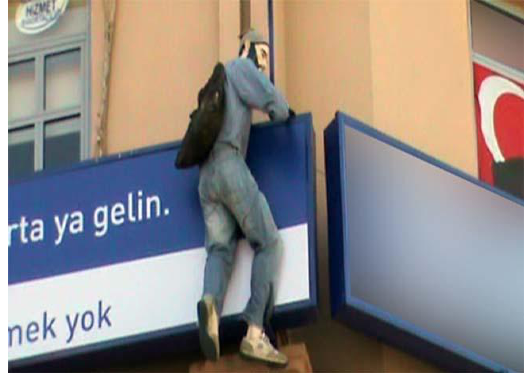
Figure 3. Lifeless mannequin in the appearance of a thief on the balcony of a building located in Istanbul Beşiktas for an insurance company